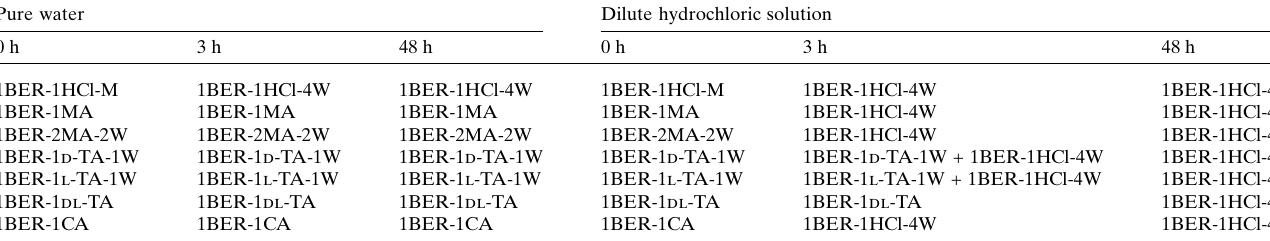
Table 5 Solid forms of undissolved samples in the solubility experiment. Pure water Dilute hydrochloric